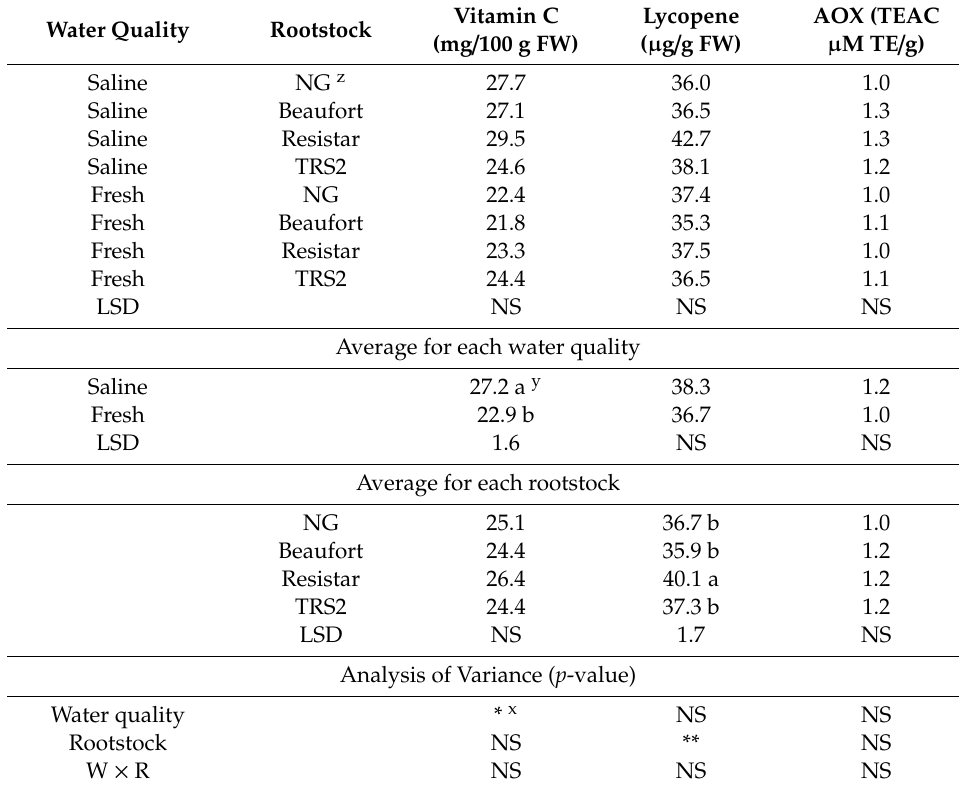
Table 3. Influence of water quality and grafting on nutritional levels in cherry tomato fruit after storage for 12 d at 12 ◦ C and 2 d at 20 ◦ C (Means of 5 harvests).